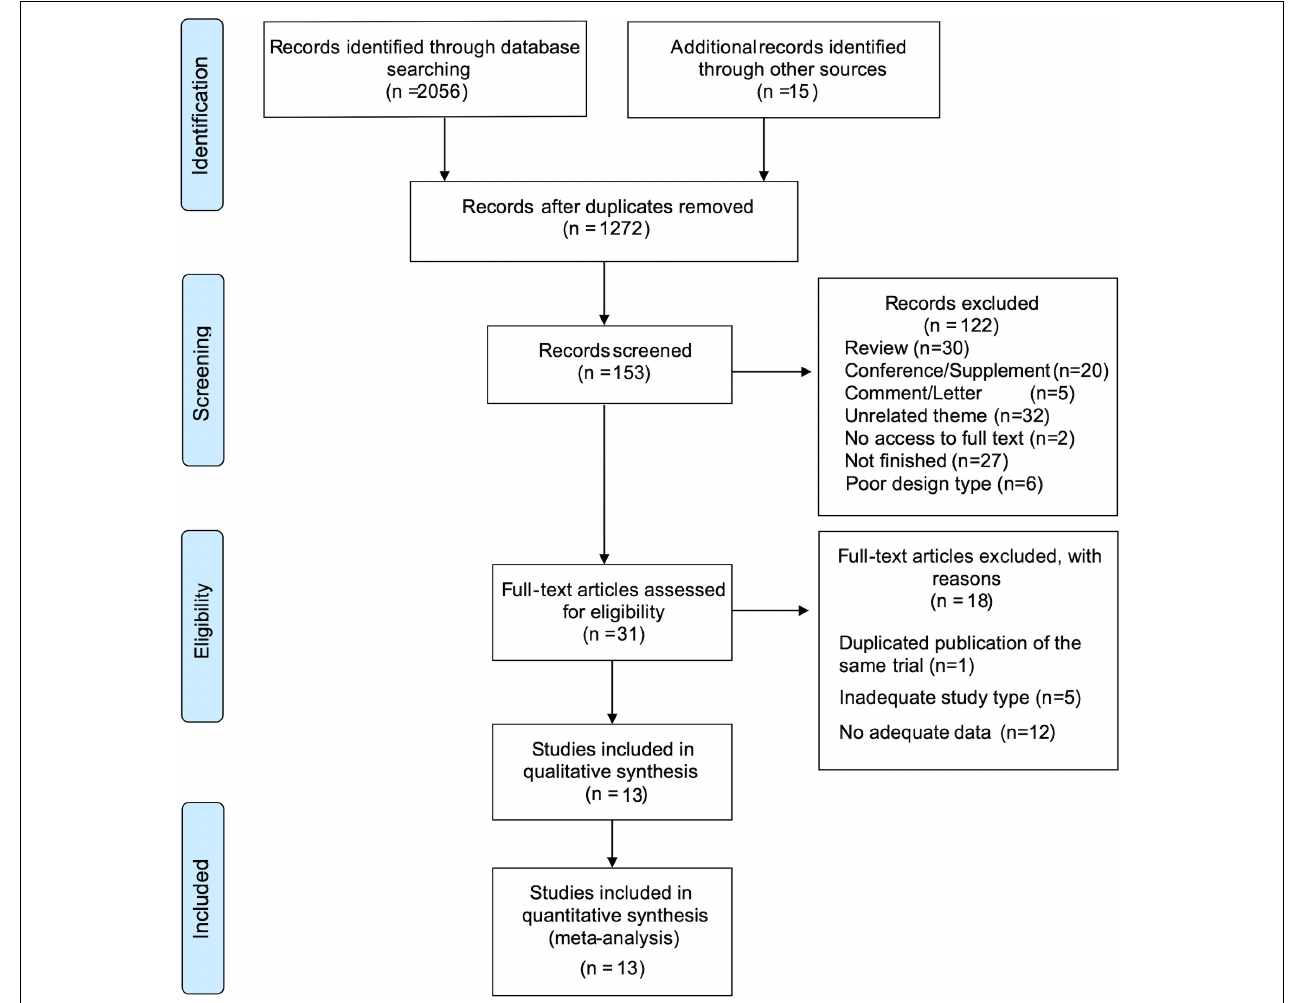
FIGURE 1 | PRISMA flow diagram depicting the study process. n, the number of records; PRISMA, Preferred Reporting Items for Systematic Reviews and